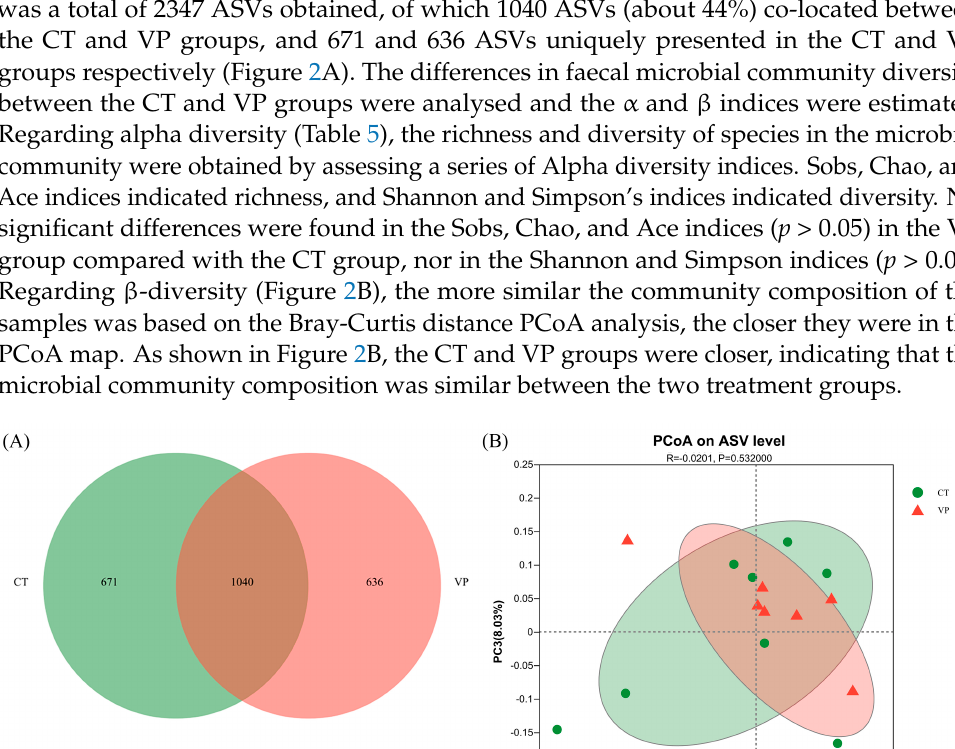
Figure 1. Effect of dietary supplementation with stimbiotics on plasma hormone levels of weaned piglets, the sign *—indicates the degree of significant difference, * p < 0.05.